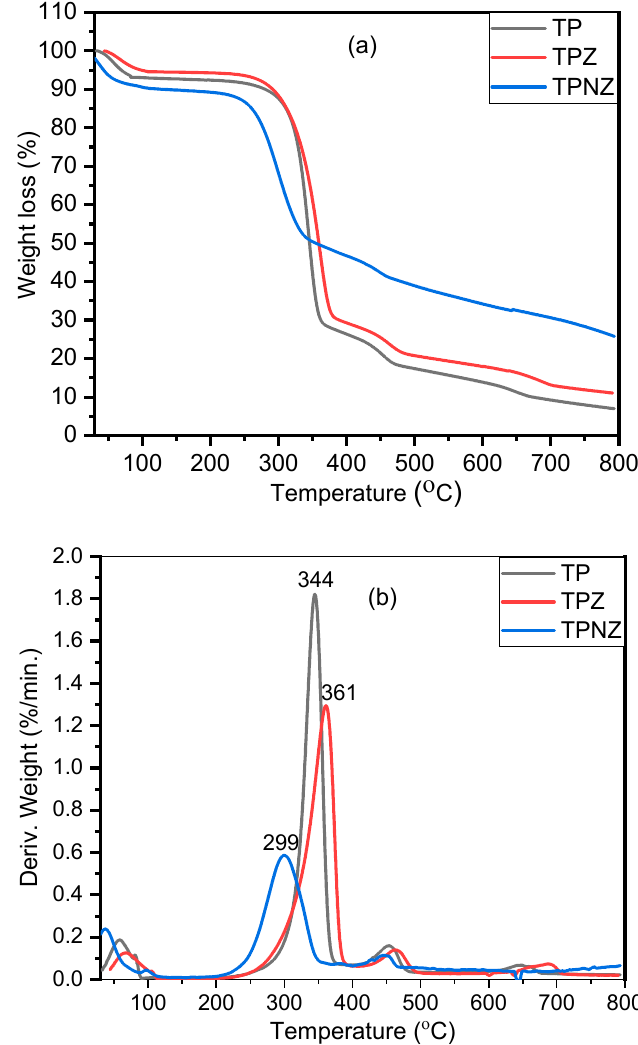
Figure 8. ( a ) TGA and ( b ) DTG of TP, TPZ, and TPNZ.